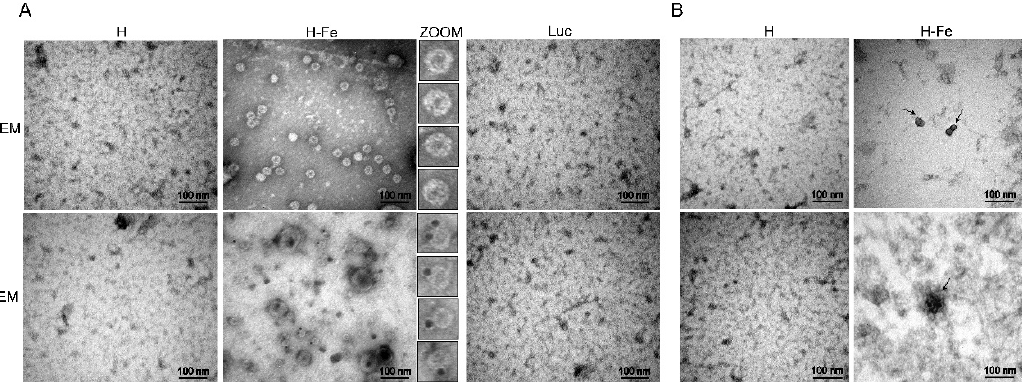
Figure 2. The TEM and IEM analyses of recombinant proteins H-Fe and H. ( A ) Electron microscopic observation of the fusion protein expressed in silkworms; Luc was expressed in silkworms as control. ( B ) Electron microscopic observation of fusion protein expressed in E. coli . TEM: transmission electron microscopy; IEM: immunoelectron microscopy. The scale bar is 100 nm.